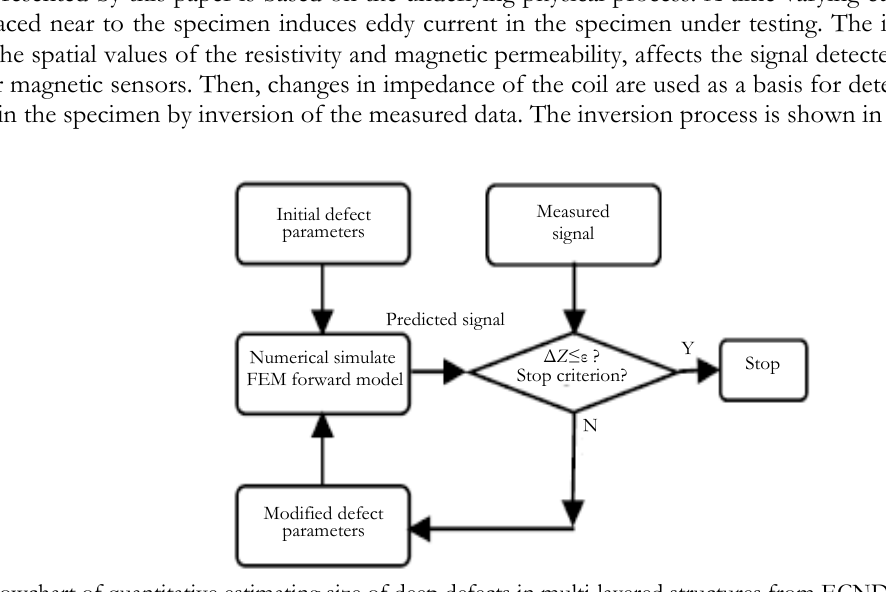
Figure 4: The flowchart of quantitative estimating size of deep defects in multi-layered structures from ECNDT signals using IACA. The measured signal at the position of the defect is assumed the target signal. A set of randomly generated initial defect parameters are given to the finite element model to predict the eddy current coil responses associated with these defects. Then, the model predicted signals are compared with the measured signal and the corresponding value of the objective function is evaluated. If the value of the objective function is less than a predefined threshold, the iterative process is terminated. Otherwise the IACA correct the defect parameters. Then the process is iterated until the error becomes less than the predefined